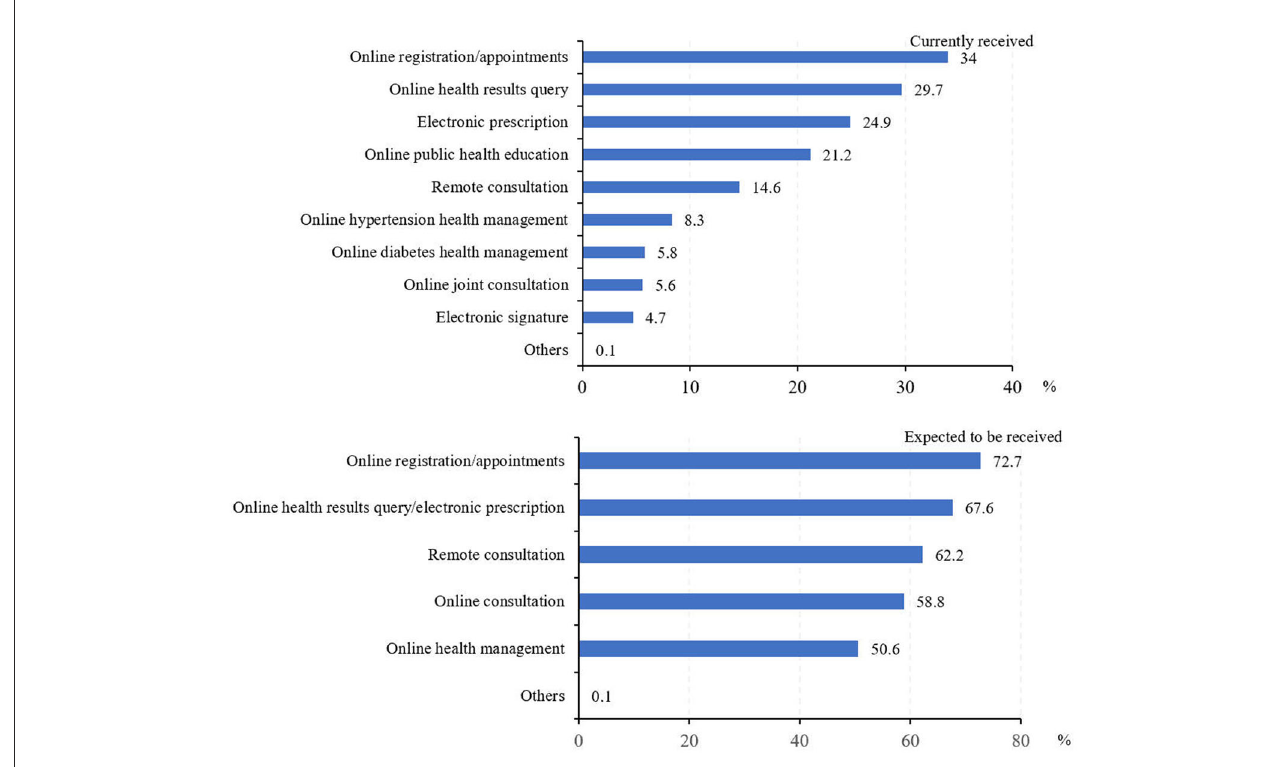
FIGURE2 Types of Internet-based primary healthcare services currently received and expected to be received (%).